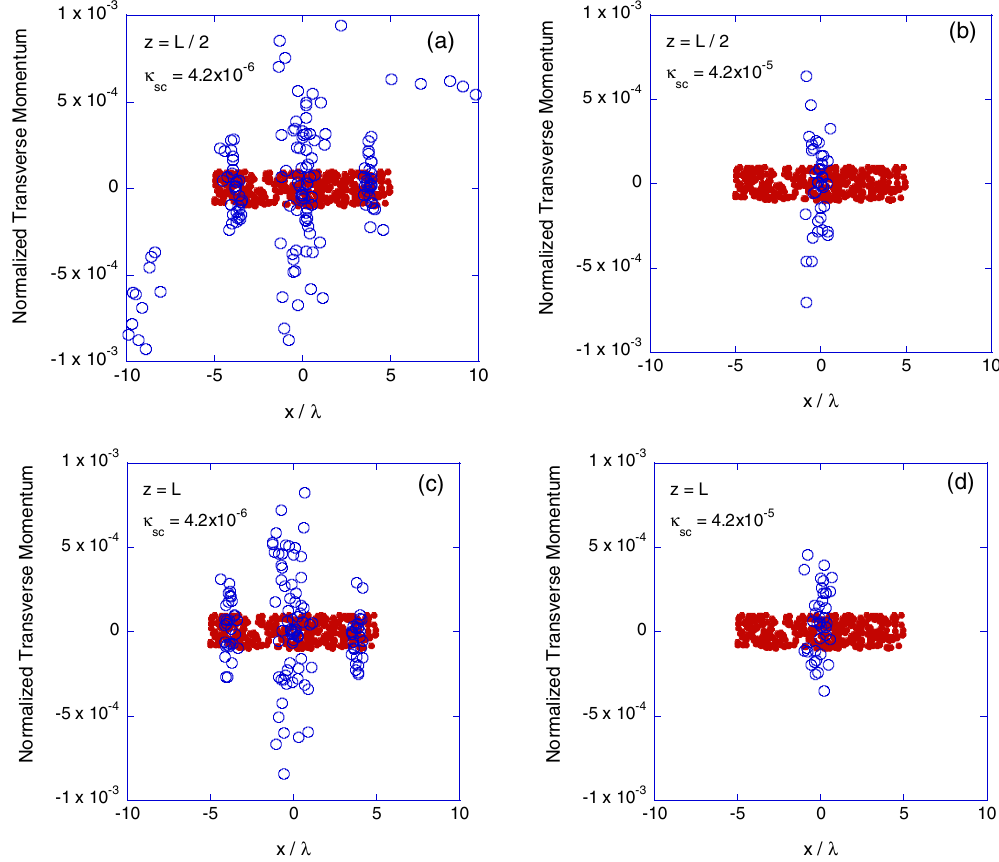
4 . 2 × 10 − 6 , z ¼ L= 2 . (c) κ FIG. 3. (a) κ SC ¼ κ 4 . 2 × 10 − 6 with the zero space-charge case κ sc ¼ z ¼ L . Elevating the charge by one order of magnitude suppresses entirely the annular